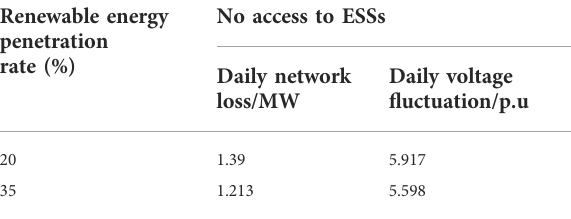
TABLE 6 Network loss and voltage fl uctuation when ESS is not con fi gured. Renewable energy No access to penetration rate (%)